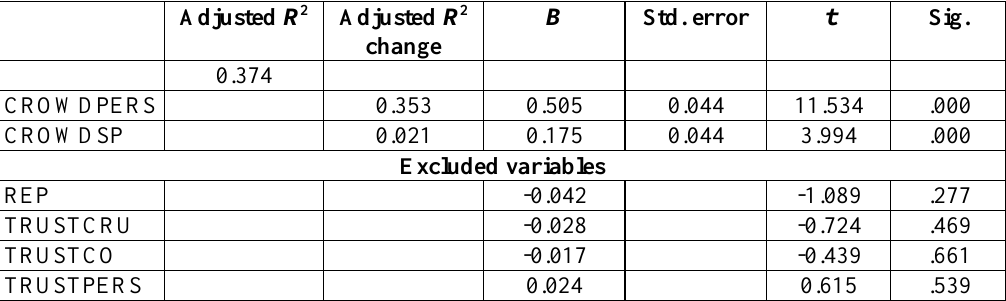
Table 1: Results of Stepwise Regression Analysis for the Perceived Health Risk